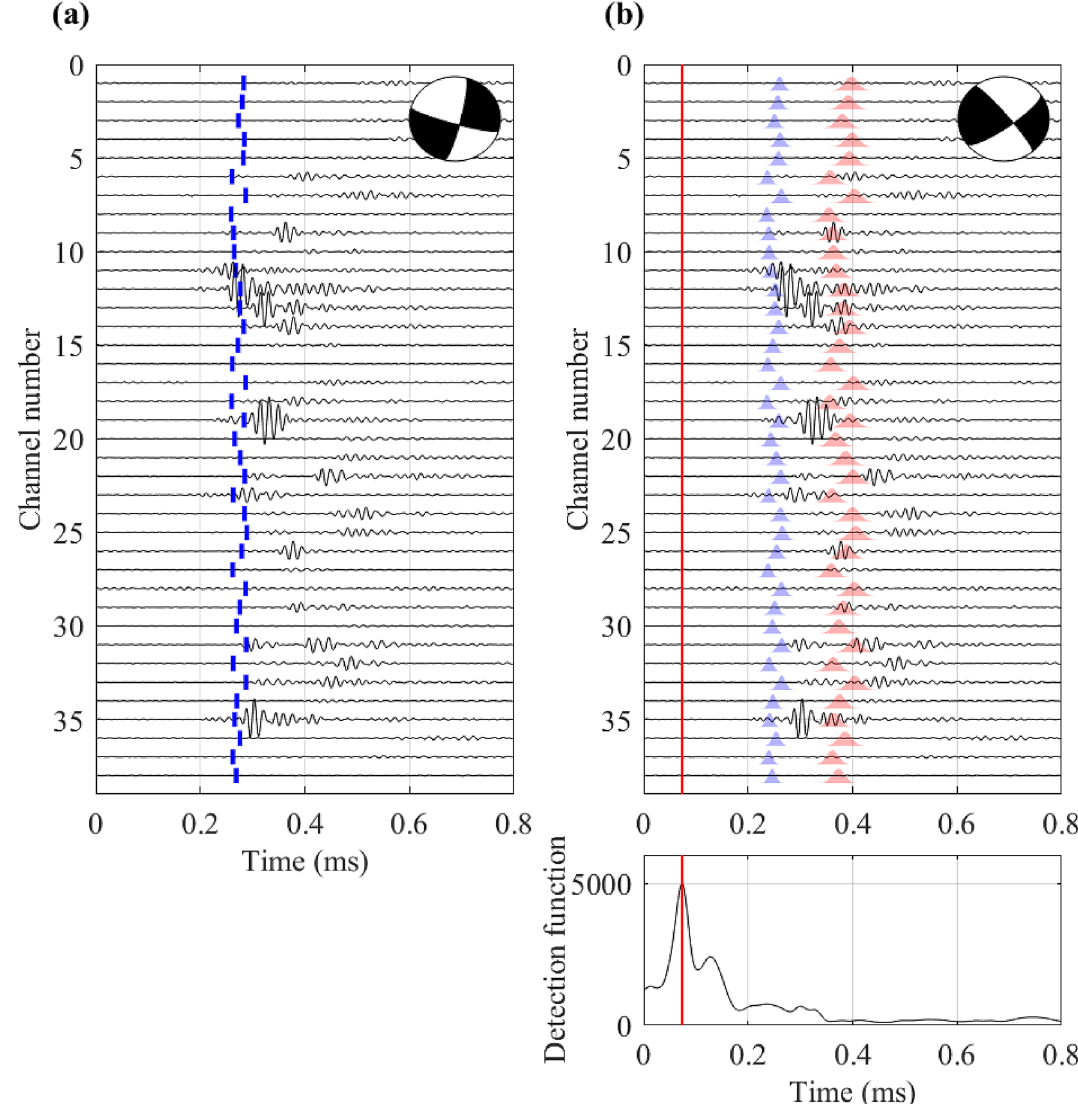
Figure 7. Comparison of theoretical travel times and source mechanism solutions. ( a ) theoretical P travel times for estimated location and fixed velocity model used in the standard method. ( b ) theoretical distributions of P (blue) and S (red) travel times computed based on deepCoSeL location and the distributions of velocities used to train the deepCoSeL model. The red vertical line is the origin time, which corresponds to the peak of the detection function plotted underneath. The difference in location results for this example is 4.2 cm. The beach ball in ( a ) is the fault plane solution derived from a moment tensor estimated with a waveform matching method that does not use data compression. The beach ball in ( b ) is the focal mechanism derived from the deepCoSeL moment tensor solution. Activation in both cases is in strike-slip. In the case of deepCoSeL the solution is aligned with the artificial